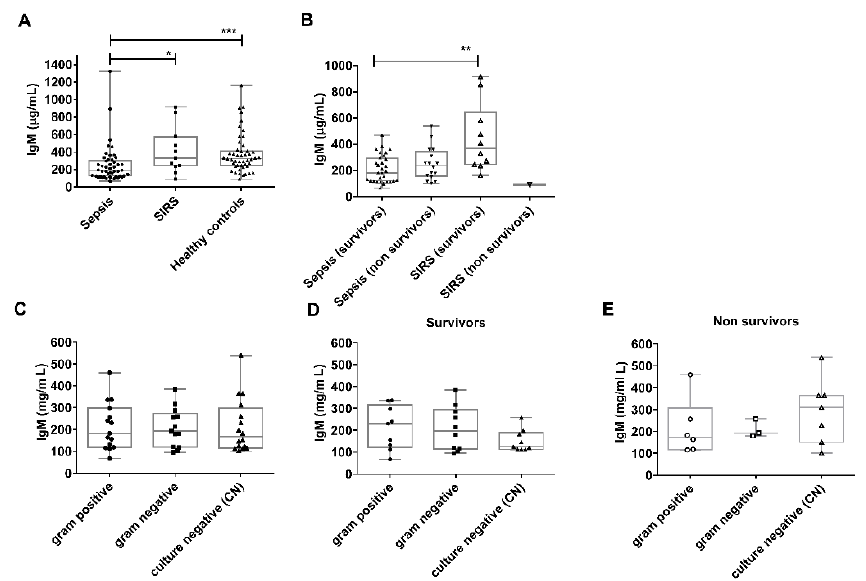
Figure 1. IgM levels in sepsis and SIRS groups. ( A ) IgM levels are decreased in sepsis compared with SIRS ( p = 0.03) and with healthy controls ( p < 0.0001). ( B ) IgM levels are not significantly different in sepsis survivors compared to non-survivors ( p = 0.31), but differed for sepsis survivors compared with SIRS survivors ( p = 0.002). ( C ) IgM levels are not significantly different in gram positive, negative or culture-negative sepsis ( p = 0.31), nor for ( D ) survivor, or ( E ) non-survivors. Boxes represent medians and inter quartile ranges, whiskers represent range. Individual values are overlayed on the plots. P values * p < 0.05, ** p < 0.01, *** p < 0.001 were determined by one-way ANOVA and Mann Whitney test. SIRS: Systemic inflammatory response syndrome.